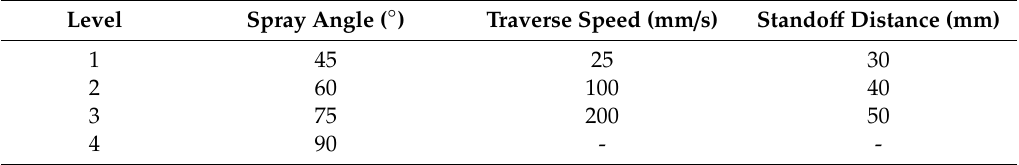
Table 1. The levels of input variables in the experimental design matrix for the Artificial Neural Network (ANN) training dataset: 4 levels for spray angles, 3 levels for traverse speed and 3 levels for stando ff